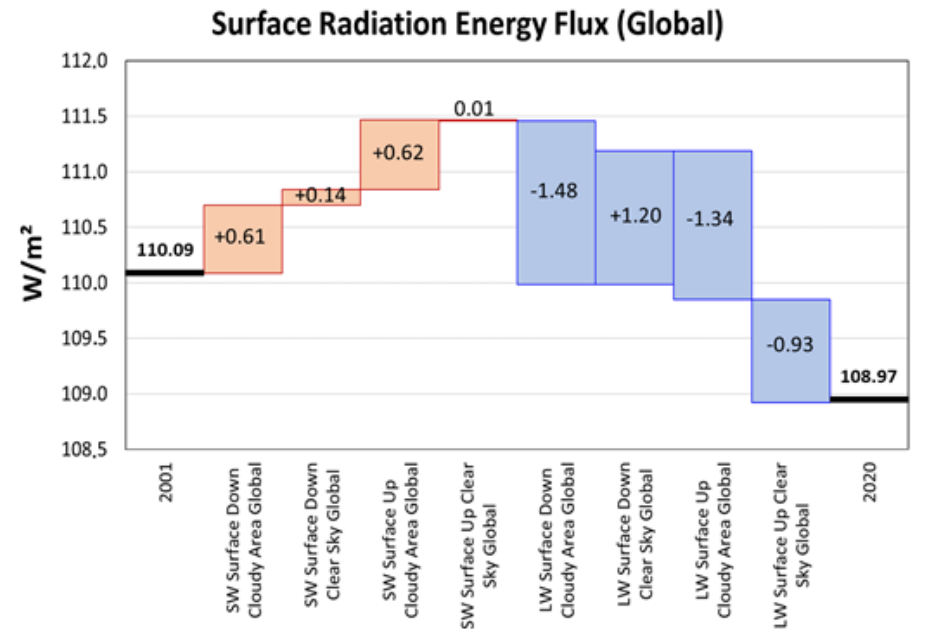
Figure 16. Bridge-chart for the actual changes at the surface from 2001 to 2020 (“start-to-end change”). Please note that the individual effects , shown in Figure 10 and Figure 11, are weighted by the cloud area fraction (ca. 1/3rd for “Clear Sky” and ca. 2/3rd for “Cloudy Areas”) and that the sign is positive for increasing downwelling or decreasing upwelling fluxes and vice versa. Reading ex- ample: “LW Surface Down Cloudy” in Figure 11c changes from 360.07 to 357.88 W/m 2 = −2.19 W/m 2 . Multiplied by 0.674 (67.4% cloud area fraction) gives a cont ribution of −1.48 W/m 2 from 2001 to 2020.